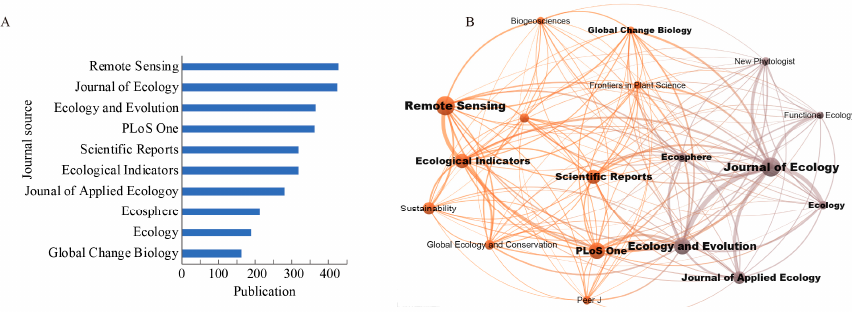
Figure 3. Ranking of journal sources by the number of publications. Subfigure A demonstrated the ranking of journal sources by the number of publications; Subfigure B showed top journal sources occurrences by the number of publications.